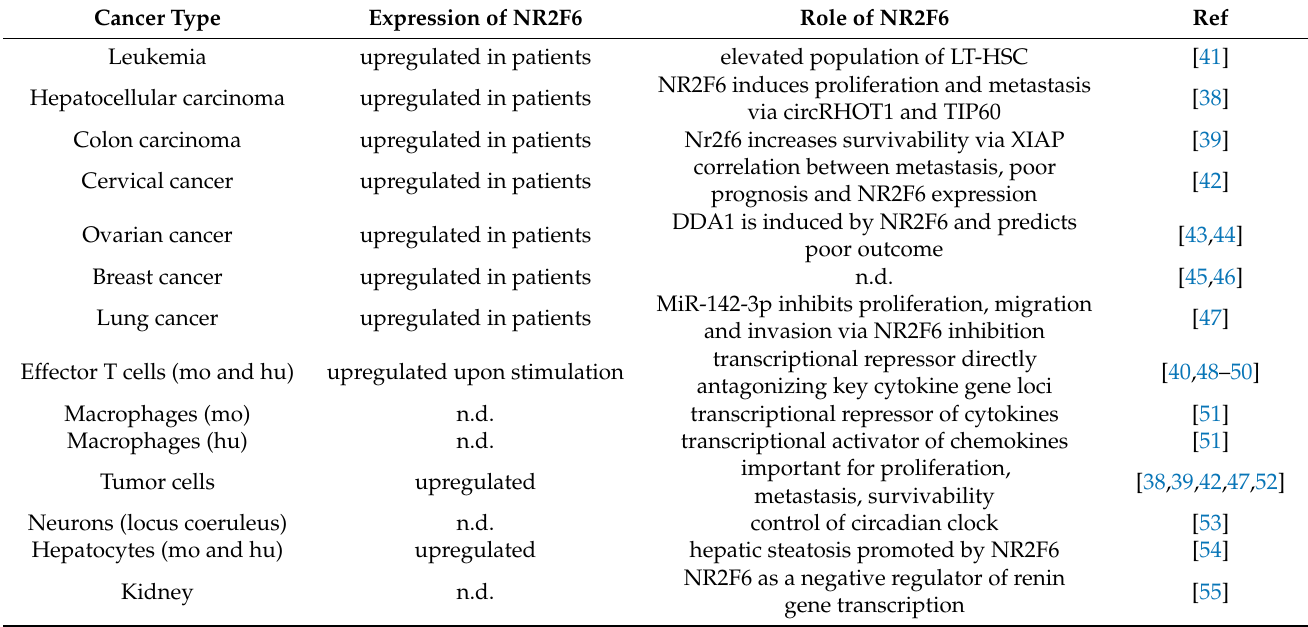
Table 1. Role of NR2F6 in various cancer and cell